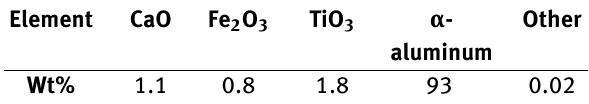
Table 1: Chemical composition of AL 2 O 3 nano material [15]